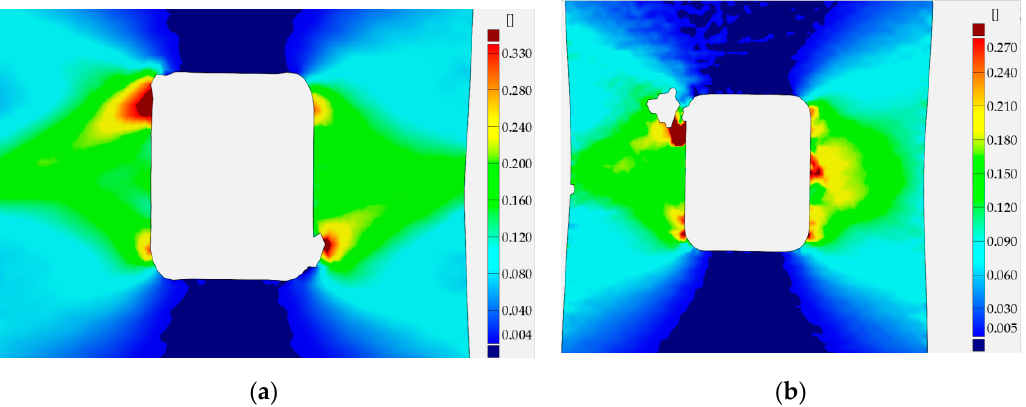
Figure 29. Distribution of strain field (DIC) in samples with square holes made of 41Cr4 + AC steel: ( a ) Sample 11; and ( b ) Sample 12.